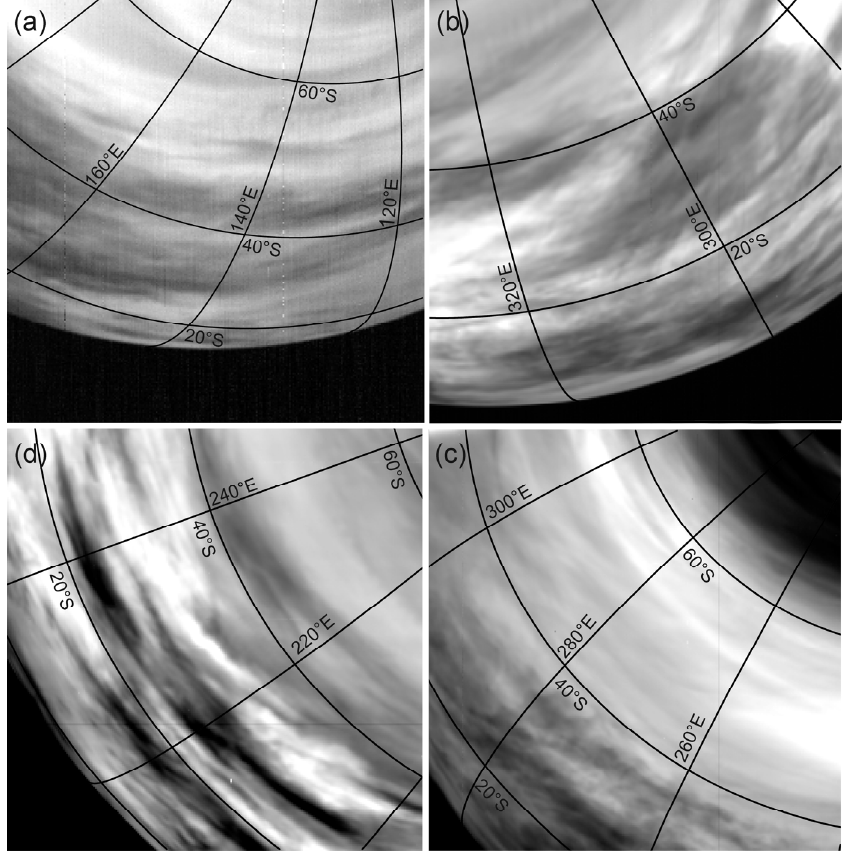
Figure 3. Examples of images by VIRTIS in 1.74 µ m, taken from a slant distance of 60,000–65,000 km: ( a ) orbit 71, data cube 01, 30 June 2006 15:06; ( b ) orbit 367, data cube 02, 22 August 2007 21:44; ( c ) orbit 569, data cube 05, 10 November 2007 16:11; ( d ) orbit 812, data cube 04, 10 June 2008 20:15. VIRTIS-M nightside images in 1.74 µ m have a low contrast value. To increase contrast of the cloud features, we used 2D-wavelet filtering with the Registax software (http: //www.astronomie.be/registax/) [18,23,24]. An example of this filter application is